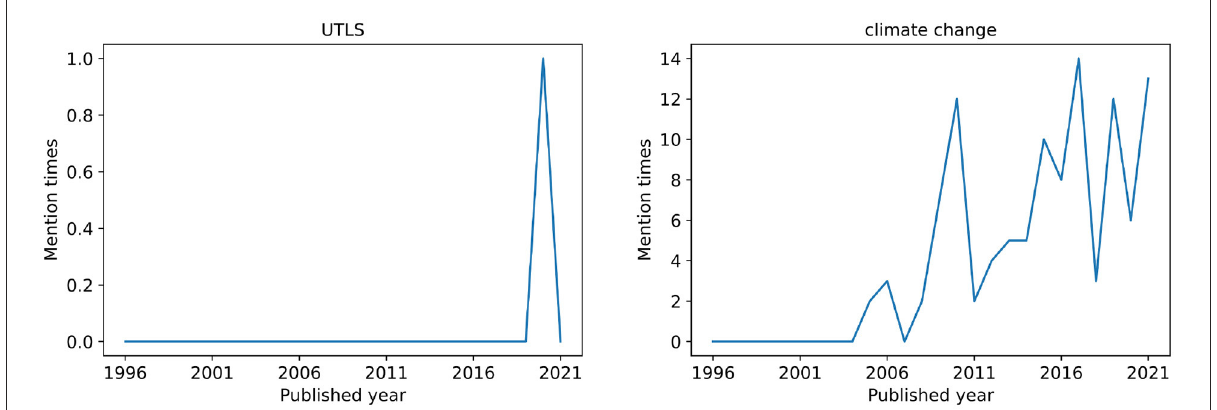
FIGURE1 Examples of keyword mention time series. Among all articles of PNAS social sciences from 1990 to 2021, only one article used the word UTLS as a keyword. The word climate change has been designated as a keyword by articles for many times since 2005, and it has been maintained in a relatively popular state.